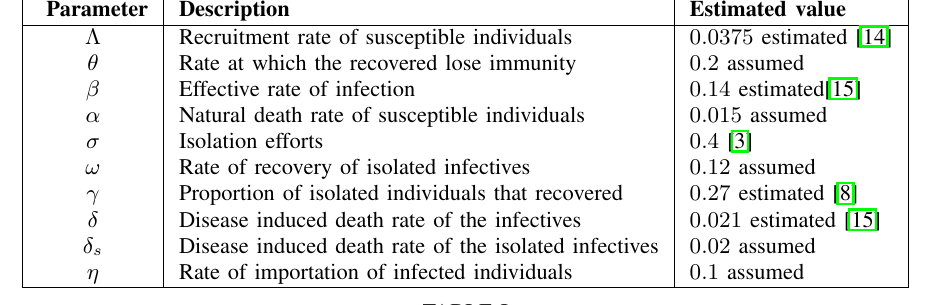
D ESCRIPTION OF BASELINE PARAMETERS FOR MODEL